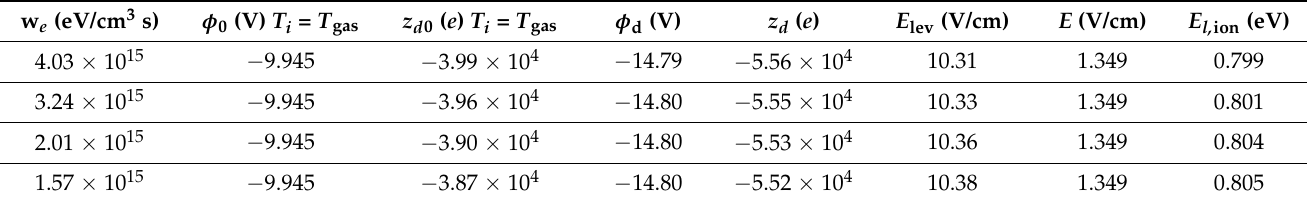
Table 4. Parameters of the RF discharge and dust particles (with radius r 0 = 5.3 µ m and density ρ = 1.5 g/cm 3 ) in the levitation area during the second series of experiments at the fixed pressure.